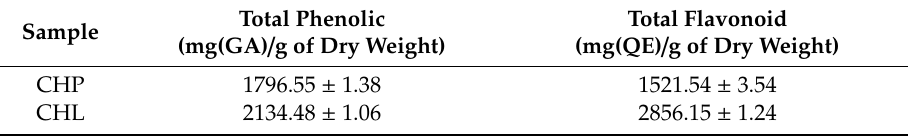
Table 3. Total phenolic and flavonoid contents of ethanolic extracts of CH.